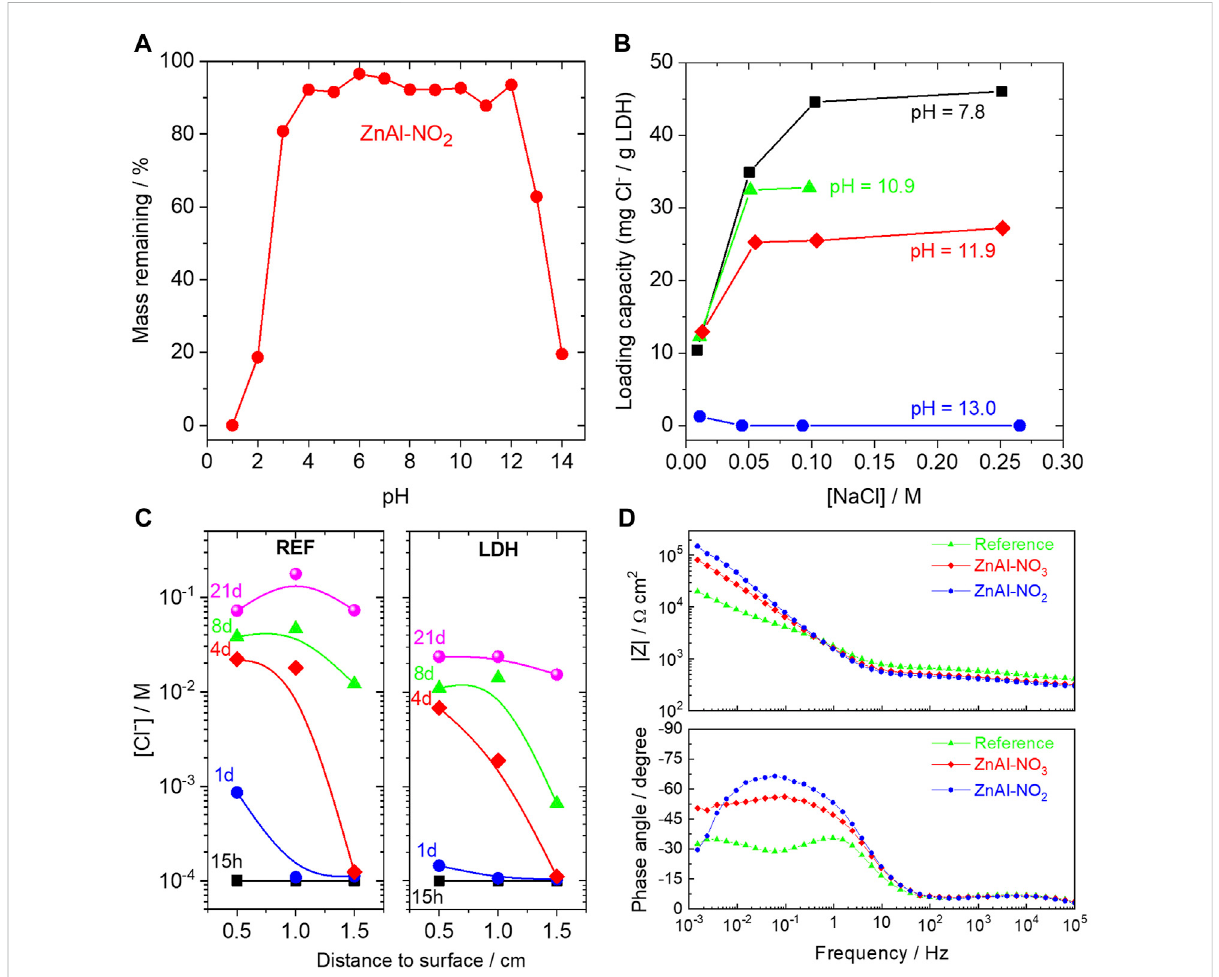
FIGURE 10 (A) LDHpowderremainingafter1monthofimmersioninwaterwithpHfrom1to14; (B) ChlorideloadingcapacityofZnAlLDH-NO 2 atdifferent pH; (C) Pro fi les of chloride ion inside mortars with LDH and without (REF) exposed to 0.5 M NaCl; (D) Impedance response of mortars with steel bar immersed in 3.5% NaCl without and with 0.3% (2% with respect to cement) ZnAl LDH-NO 3 or ZnAl LDH-NO 2